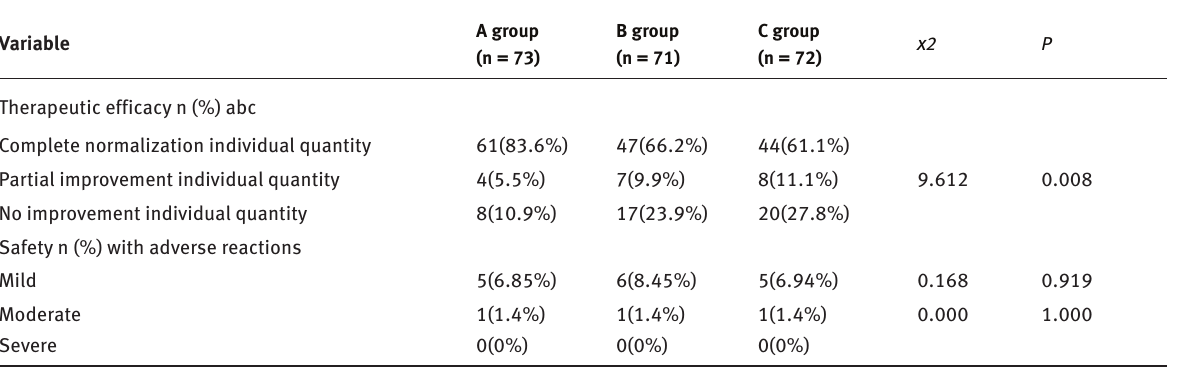
Table 2: Comparison of the efficacy and safety of treatment in the three groups